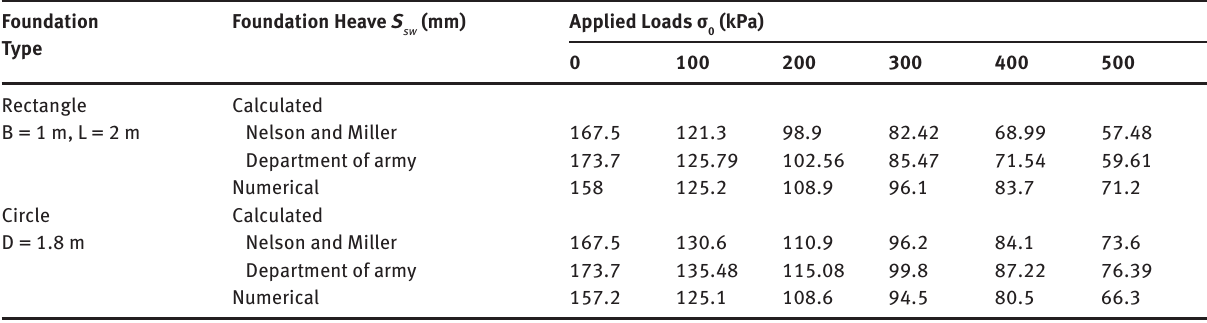
Table 3: Heave prediction for each type of isolated shallow foundations from numerical and analytical analysis.